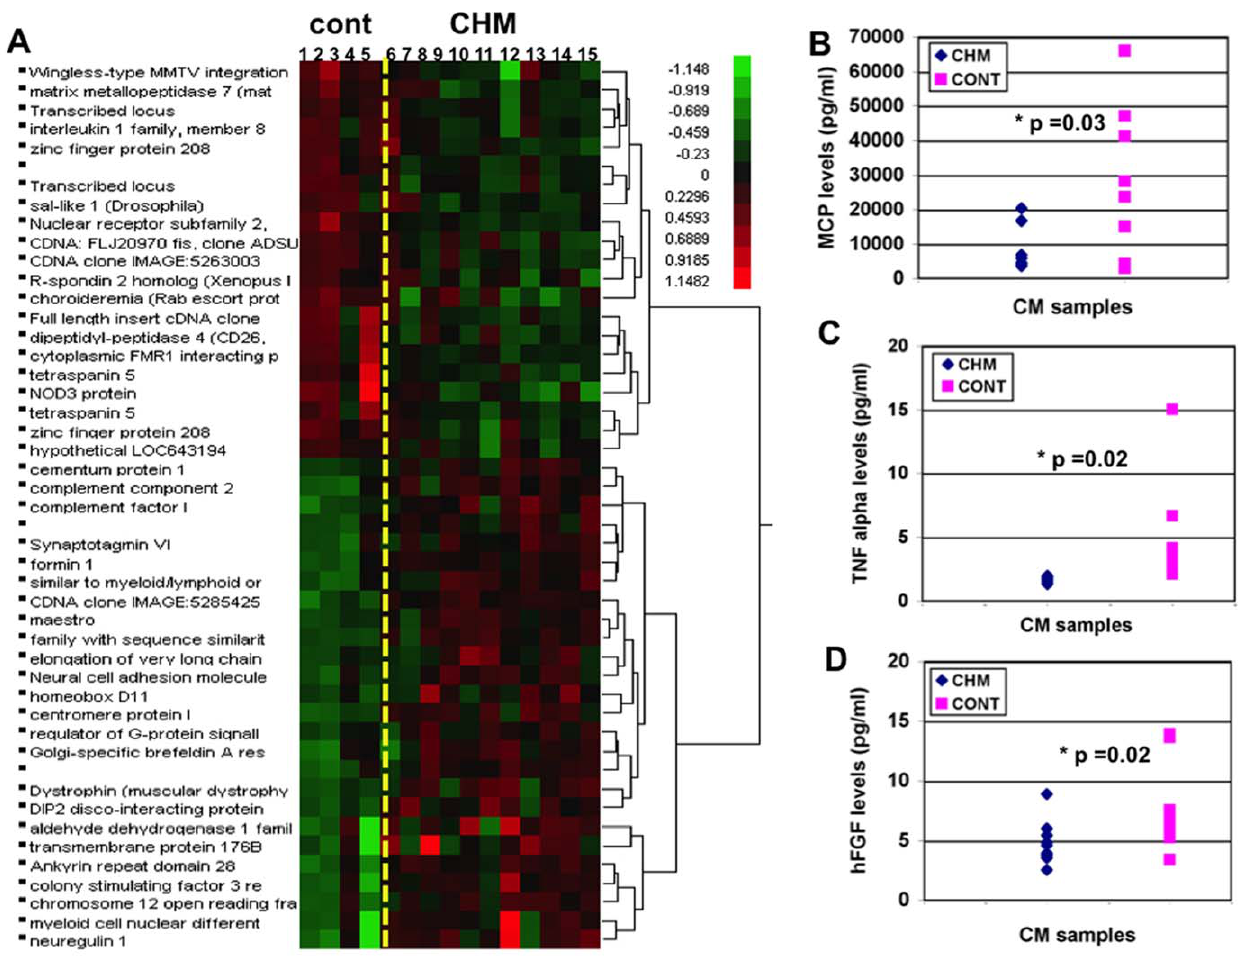
Figure 7. Mutation in REP-1 affects gene expression and secretion in CHM patients. a. Hierarchical cluster of 47 probe sets in control and CHM samples. Using consistency testing, twenty-six probe sets were found to be significantly over-expressed and 21 under-expressed in monocytes and primary fibroblasts cells from CHM patients 43 (CHM 6-15) compared to control (Cont 1-5)(p , 0.0001, FDR30%) b-d. Level of secretion of the cytokines and growth factors by primary fibroblast cultures into conditioned media. MCP-1, TNF-alpha and FGF factors were detected at significantly higher levels in samples collected from the control cells (n=9) compared to conditioned media samples from 8 CHM patients (p , 0.005)